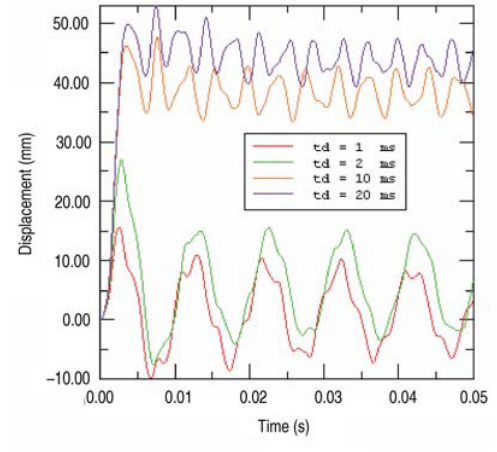
Fig. 3. Influence of stiffener configurations d